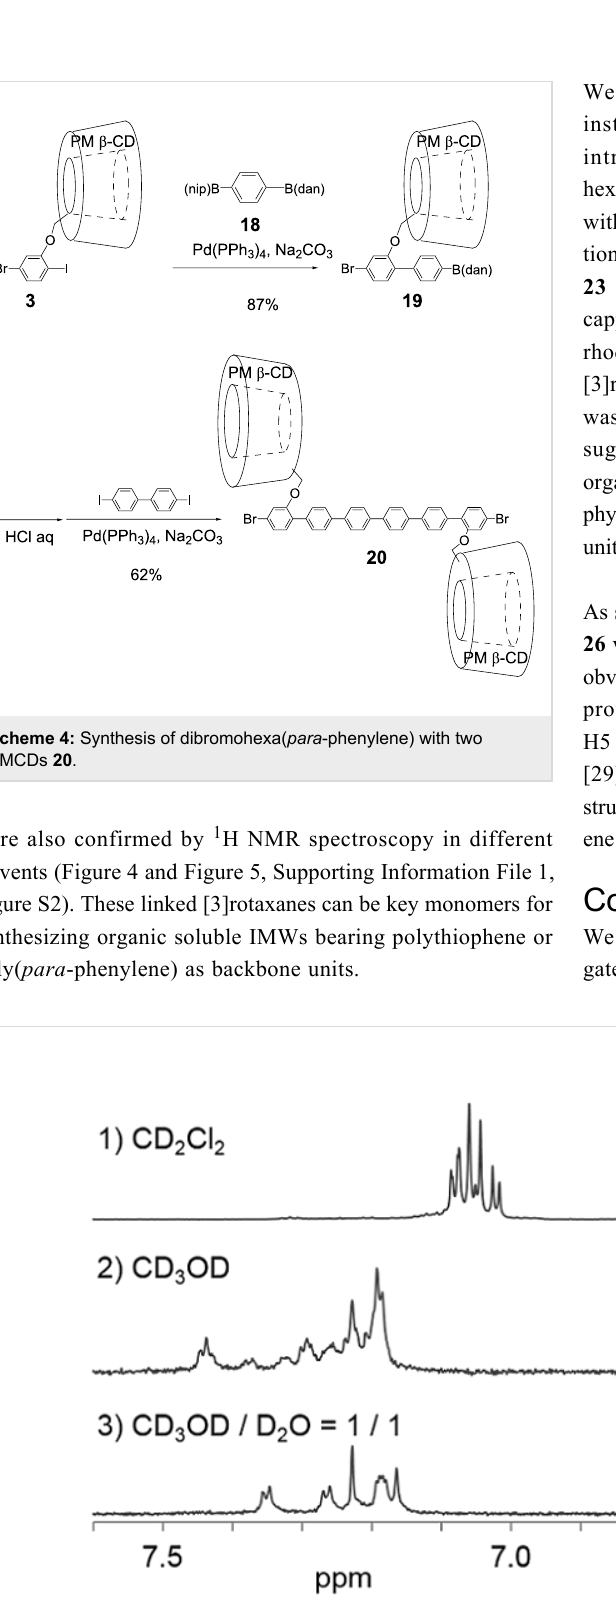
Figure 4: The aromatic region of the 1 H NMR spectra of 5 at 25 °C: 1) CDCl 3 , 2) CD 3 OD, and CD 3 OD/D 2 O 1:1.